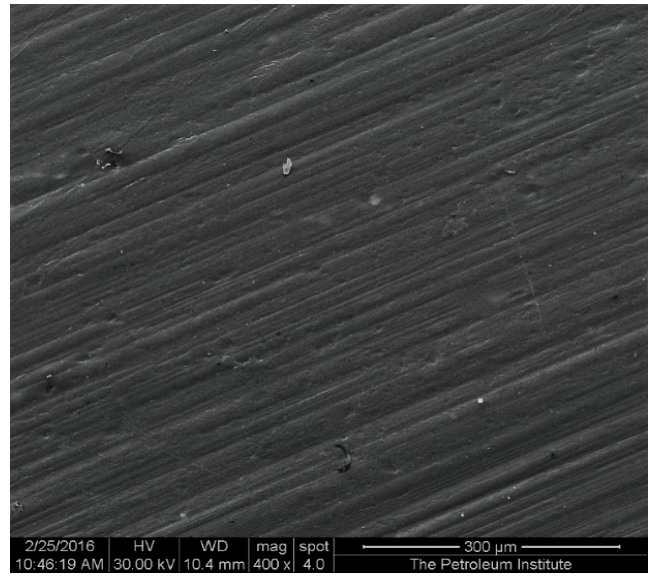
Figure 2. Representative secondary electron (SE) SEM micrograph of HDPE/TiO 2 composites with 5 wt % nano-TiO 2 prepared at a barrel temperature of 250 °C for 30 min residence time. Image taken at 400× magnification and scaled to 300 micrometers.